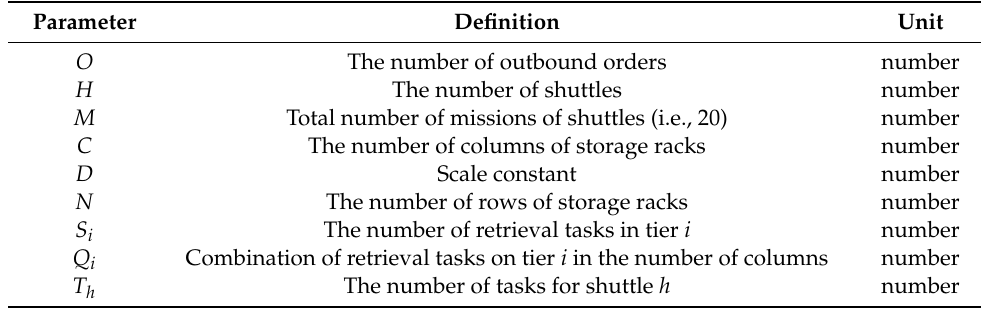
Table 2. Parameters and meanings.